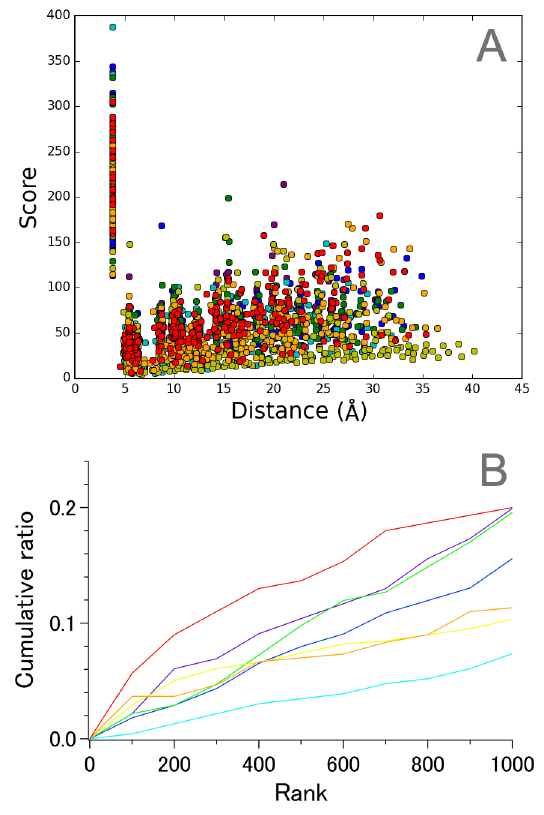
Figure 4. DSA results for 1,992 intrahelical pairs in set 3. A . Correlation between score and average distance. B . Cumulative ratio of the number of C −C pairs in the top-ranked 1,000. Coloring α α of the plots is the same as that in Figure